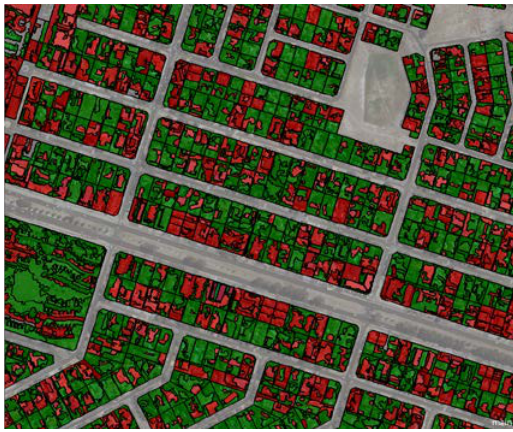
Figure 9: Object-based classification using the Nearest Neighbour method (initial segments derived from thematic information)